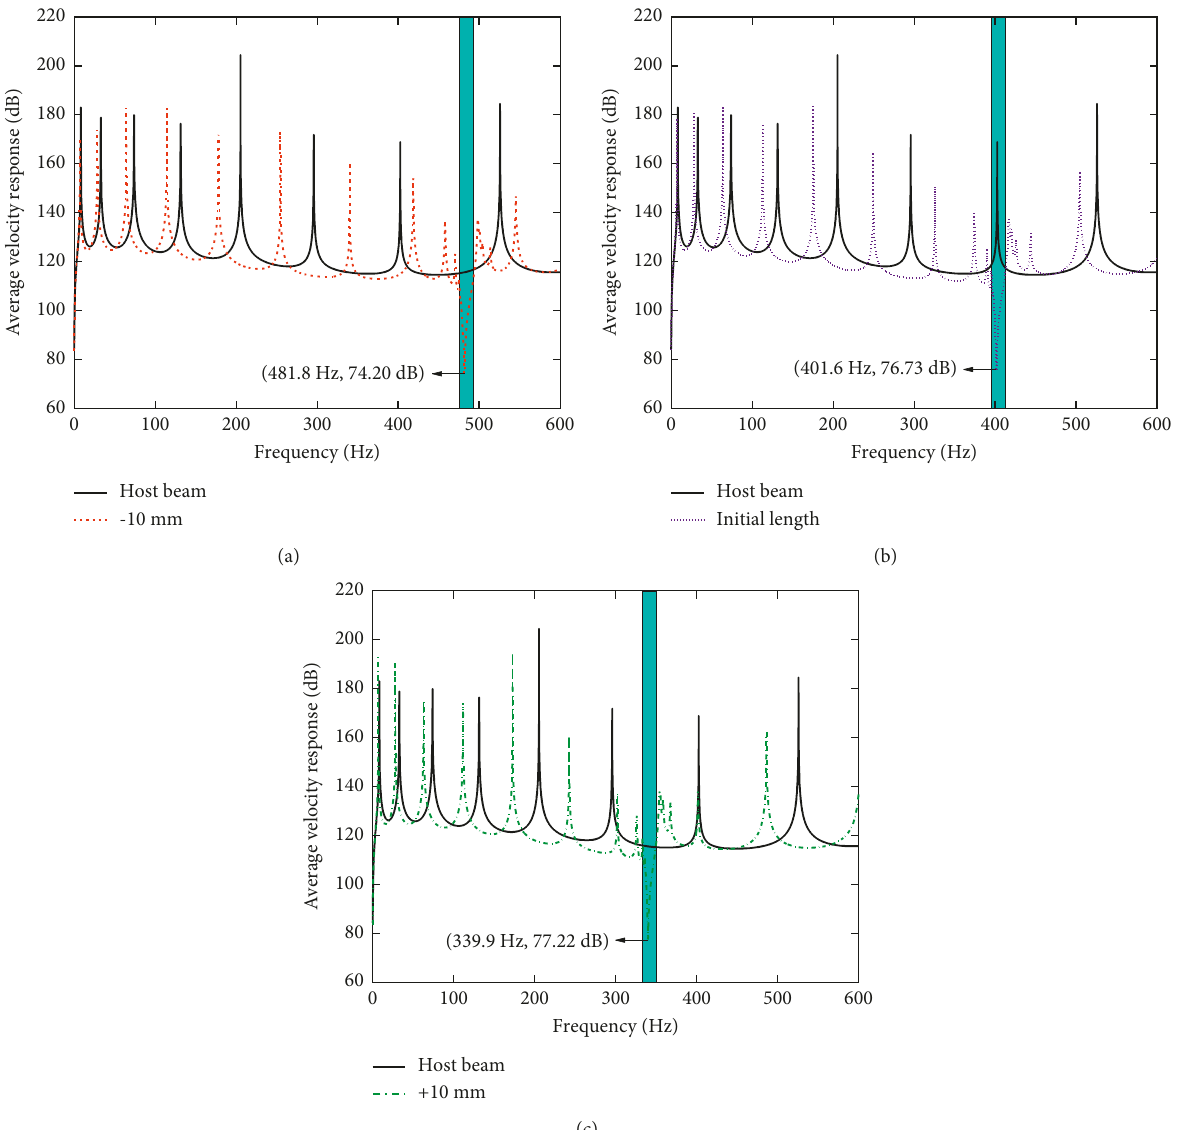
Figure 8: Influence of the beam-like resonator’s length on the vibration properties of the locally resonant